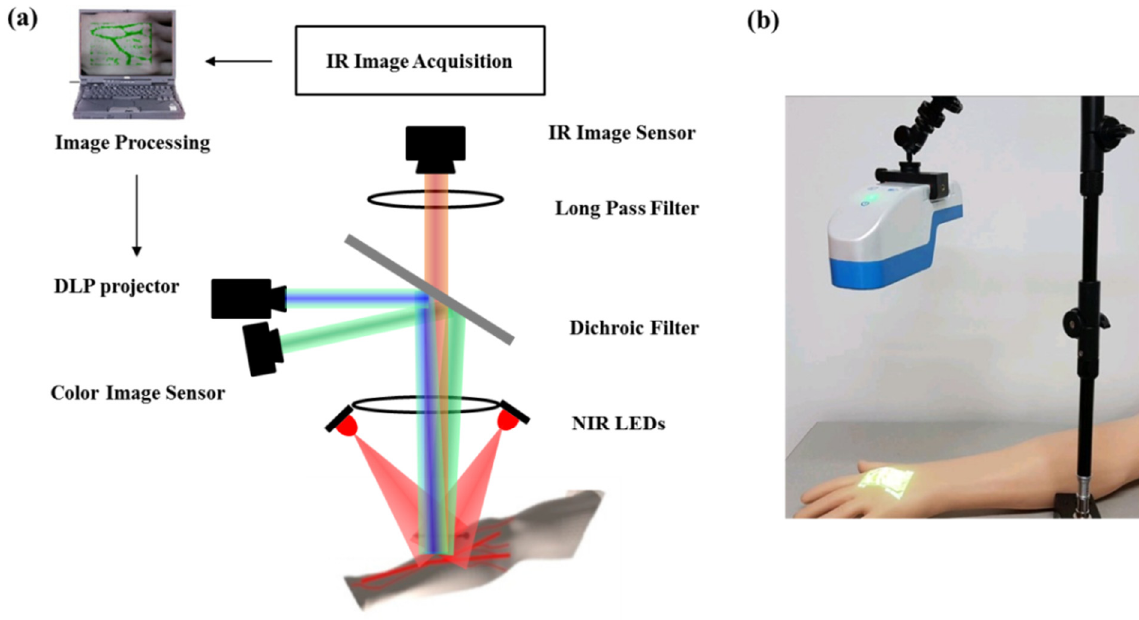
Figure 1. ( a ) Schematic of the developed vein viewer system configuration; ( b ) photograph of the system.